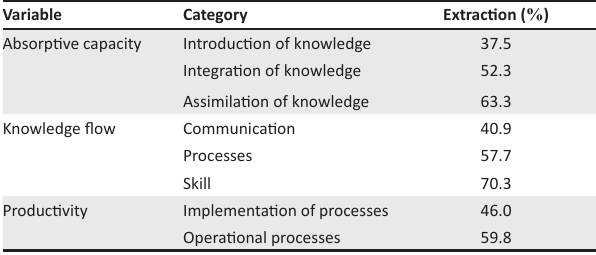
TABLE 2: Internal reliability and factor analysis results. TABLE 3: Percentage extraction of